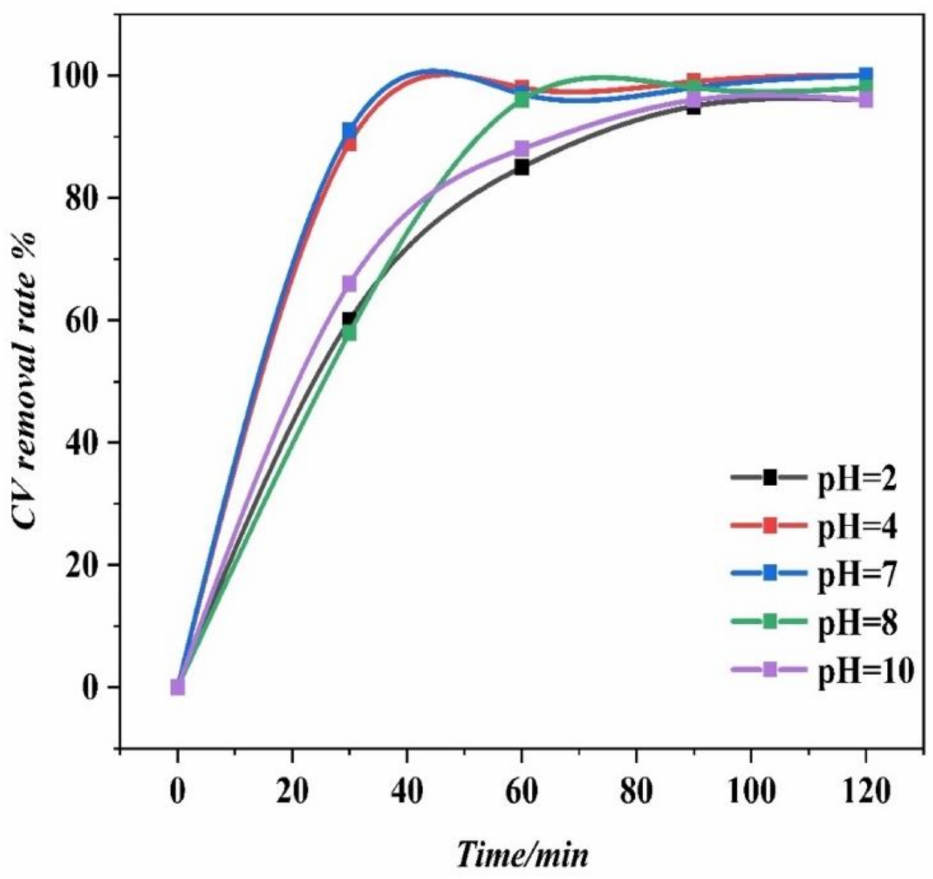
Figure 5. Effect of initial pH of CV removal ([CV] 0 = 10 mg L − 1 , i = 50 mA cm − 2 and temperature = 25 ◦